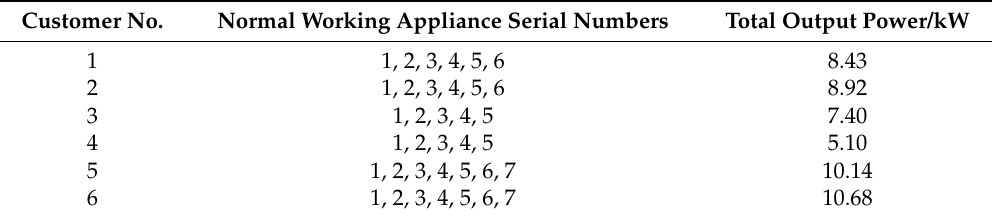
Table 3. Actual work status of home appliances of each customer.